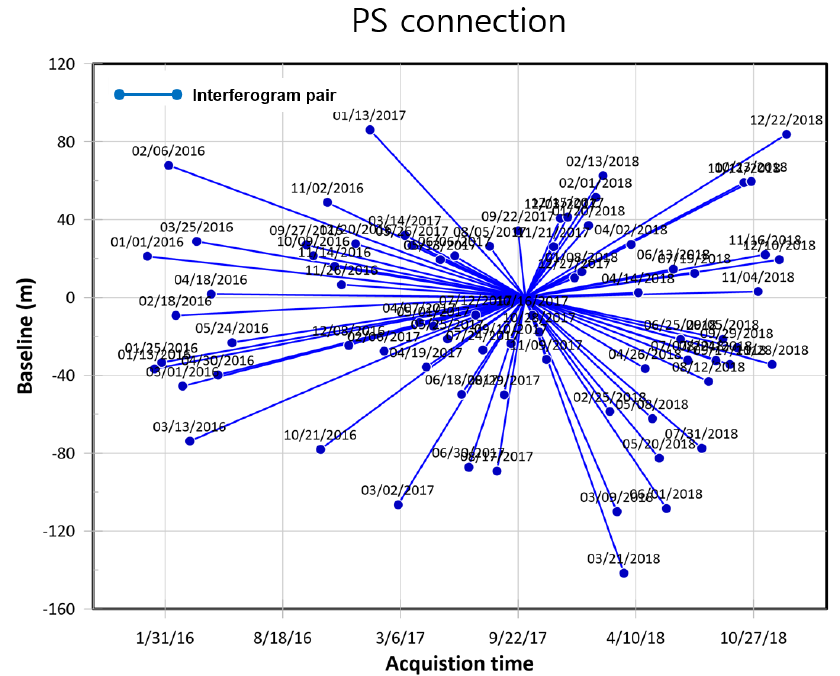
Figure 3. Connection graphs of employed Sentinel-1 InSAR pair as shown in 72 descending images employed for PS time series analysis.